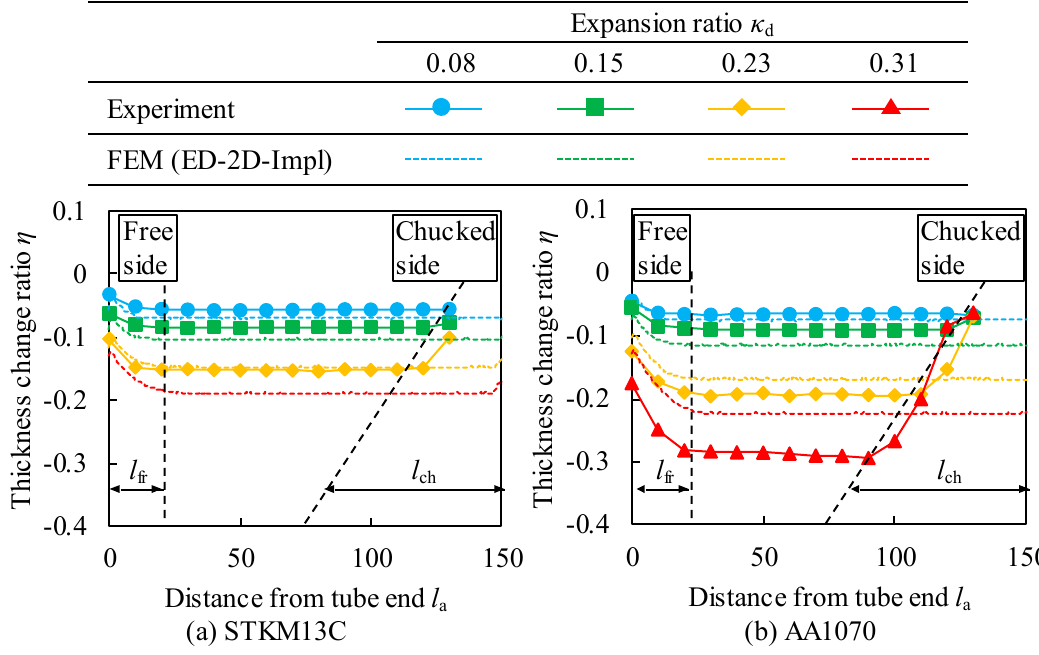
Figure 15. Distribution of thickness change ratio η in axial direction by drawing process.